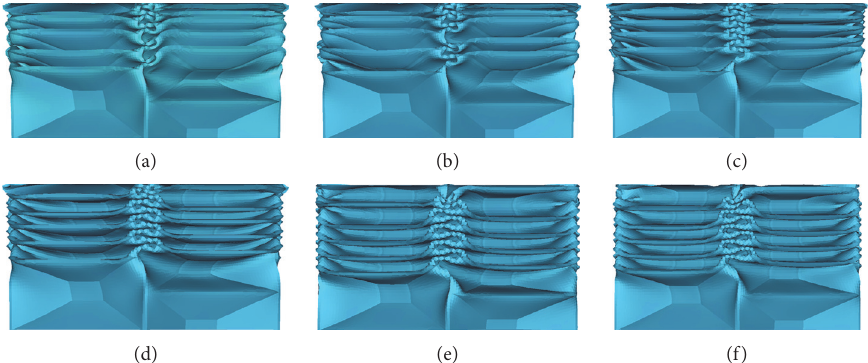
Figure 10: Deformation modes of the square prefolded tubes with various values of B / t . (a) S6_1 ( t � 3mm). (b) S6_2 ( t � 2.5mm). (c) S6_3